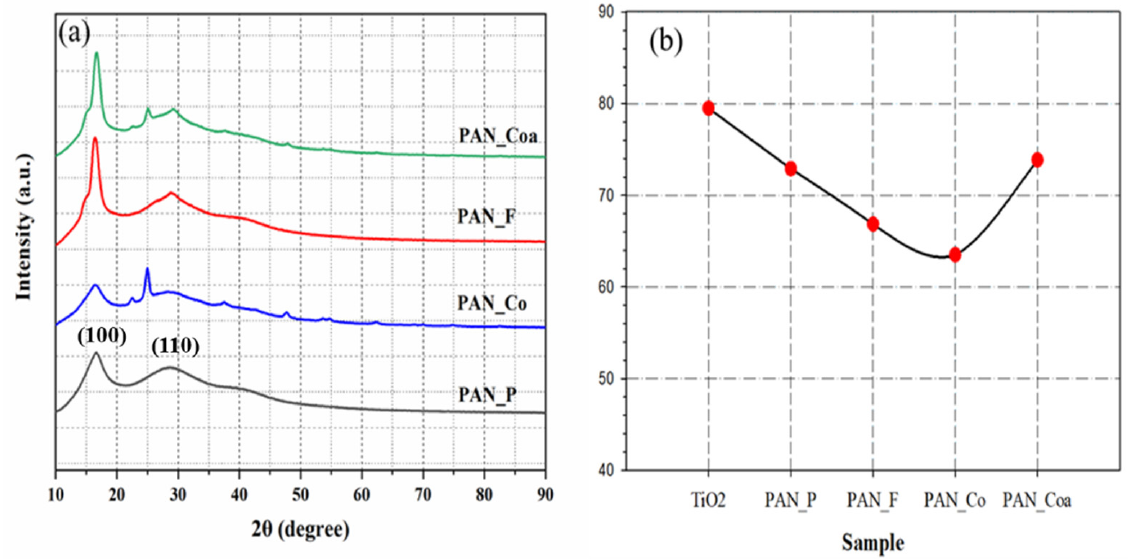
Figure 4. ( a ) XRD plots of PAN_P, PAN_F, PAN_Co and PAN_Coa NFs membranes and ( b )% crystallinity calculated with Origin 18 software from the XRD plots in Figures 2 and 4.